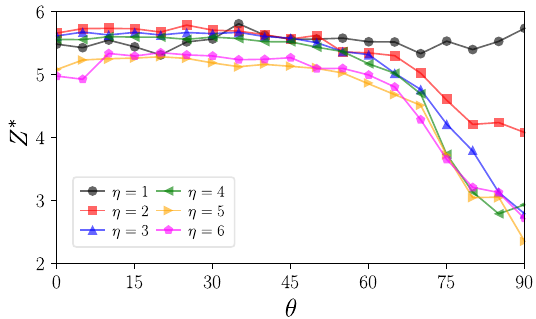
Figure 6. Evolution of the coordination number at the onset of failure as a function of ⌘ and loading orientation ✓